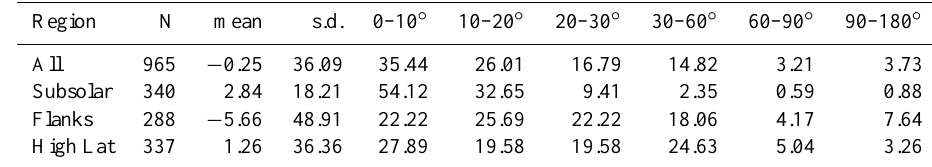
Table 10. Distribution of angular differences in the high pressure case (solar wind dynamic pressure > 2nPa). Format as in Table 3. Region N mean s.d. 0–10 ◦ All 641 − 0.53 Subsolar 162 Flanks 342 − 0.32 High Lat 137 − 8.49